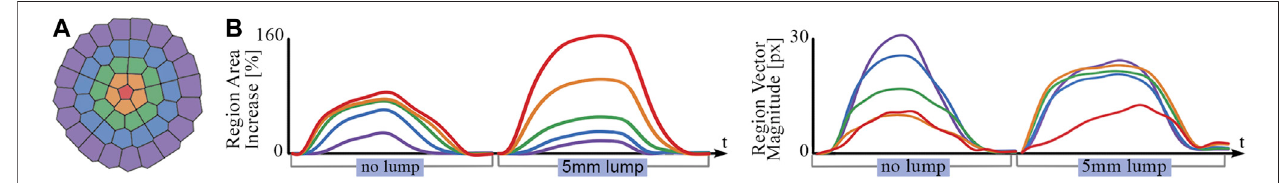
FIGURE 10 | (A) Voronoi regions colored by radial distance from centroid. (B) Ring-averaged area and vector displacement magnitude response to a fl at plate (no lump) in comparison to a 5 mm surface lump. This example shows data taken at a baseline pressure of 50 mbar and with a normal indentation force of 3 . 5 N into the surface. When a 5 mm lump is present, the central rings ’ response changes signi fi cantly compared to the outer rings ’ .